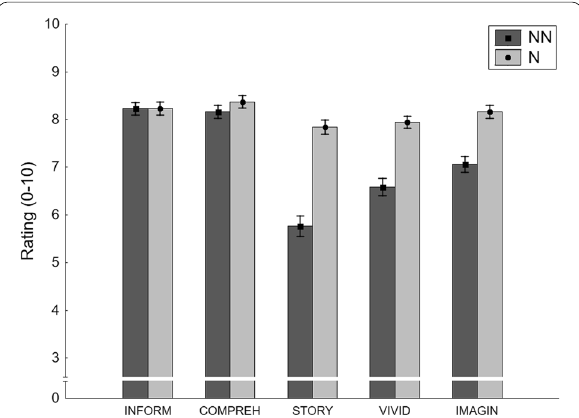
Fig. 6 Ratings of non-narrative (NN) and narrative (N) event-report corrections on informativeness (INFORM), comprehensibility (COMPREH), story-ness (STORY), vividness (VIVID), and imaginability (IMAGIN) in the Experiment 1 Pilot. Error bars indicate within-subjects standard error of the